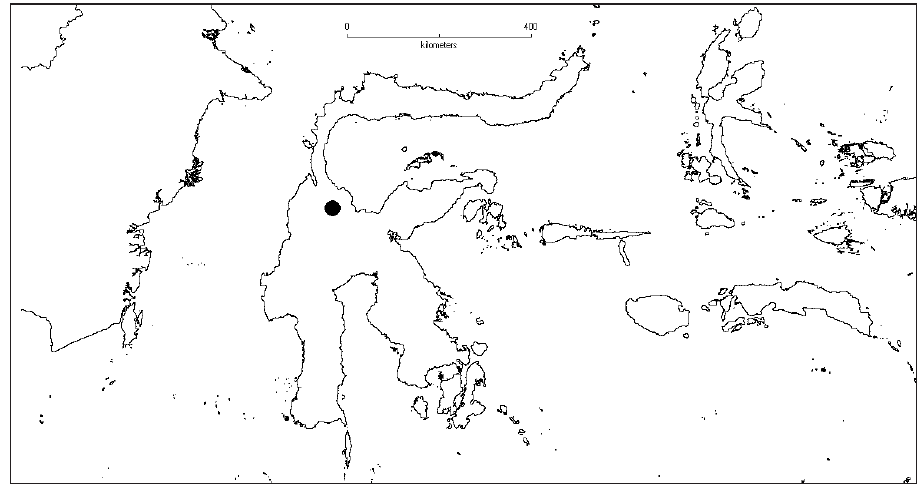
Map 9. Distribution of D. celebica var. longilobata ( ●